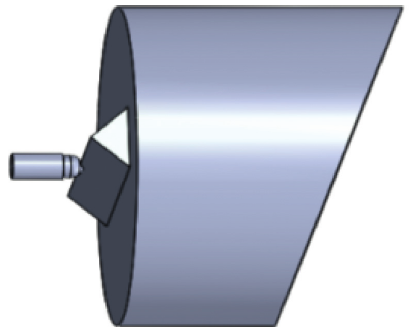
Figure 11: 3D model with inclined